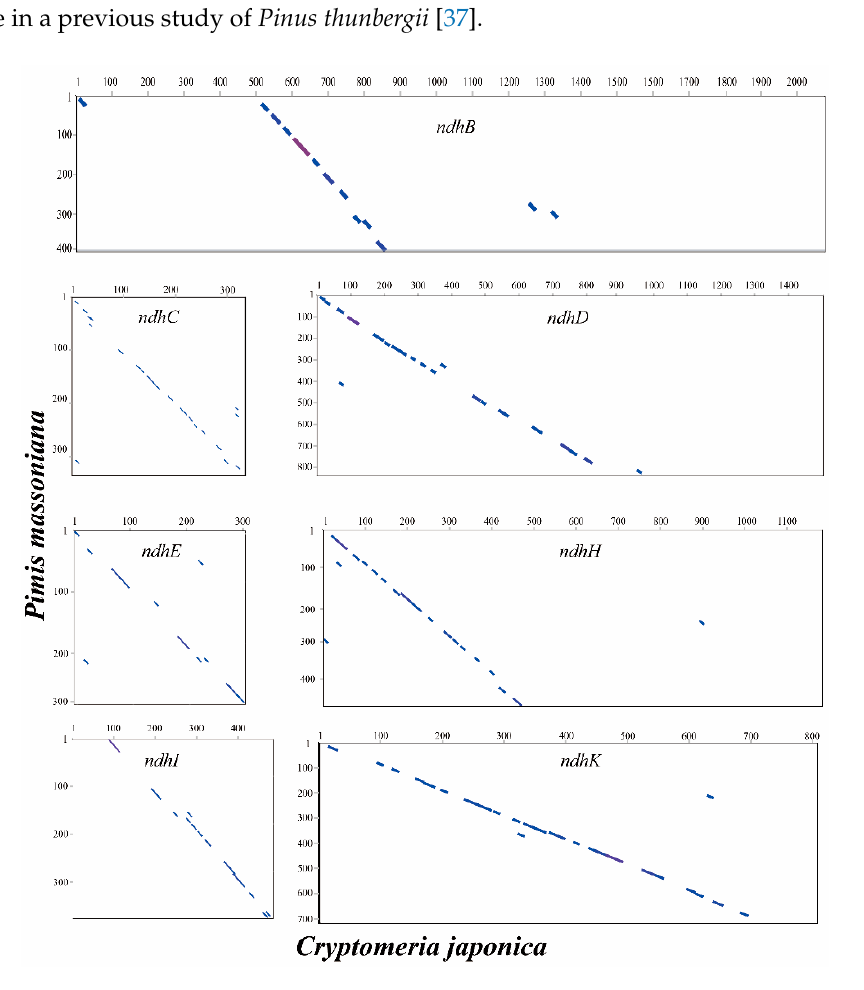
Figure 4. Dotpot analysis of seven ndh genes between P. massoniana and Cryptomeria japonica.